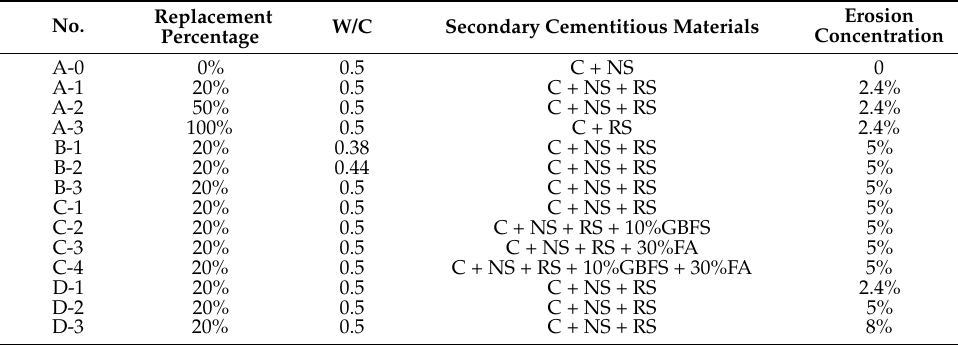
Table 6. Details of specimens for shrinkage tests.